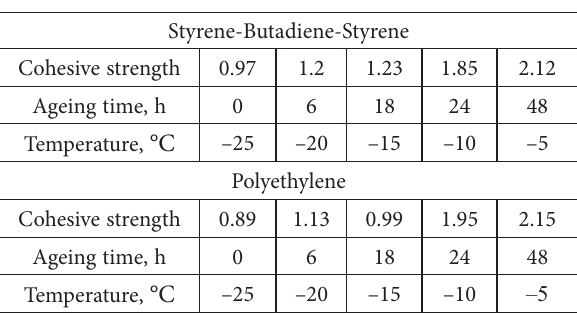
Table 4. The reference and comparison sequences of modified